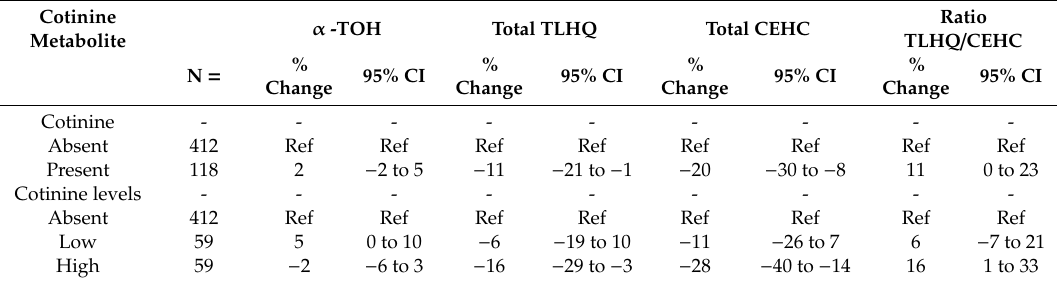
Table 3. Associations between cotinine and di ff erent measurements of vitamin E activity. Cotinine